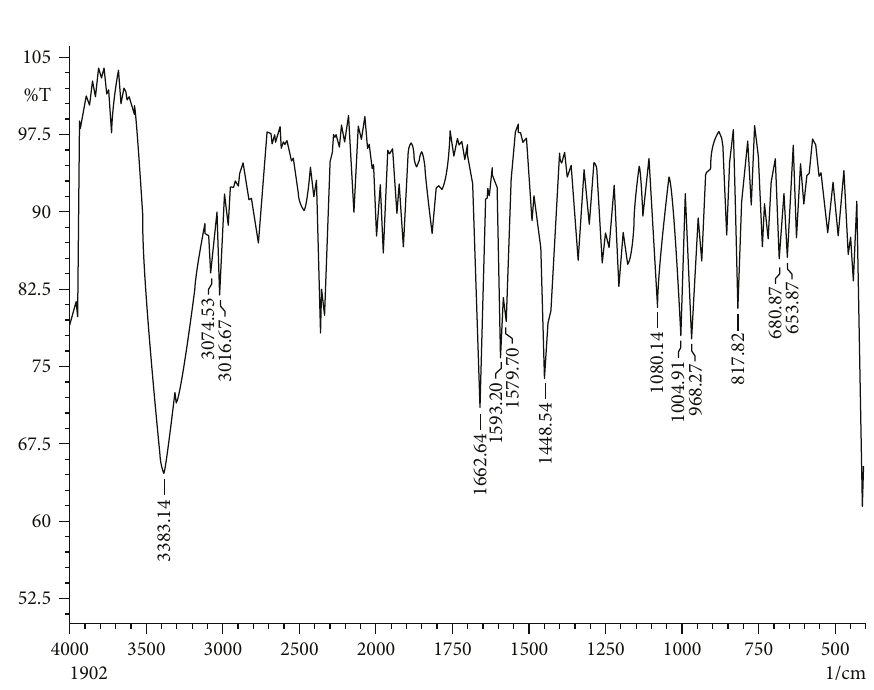
e ffi cient building block for the synthesis of 1,2-azoles.